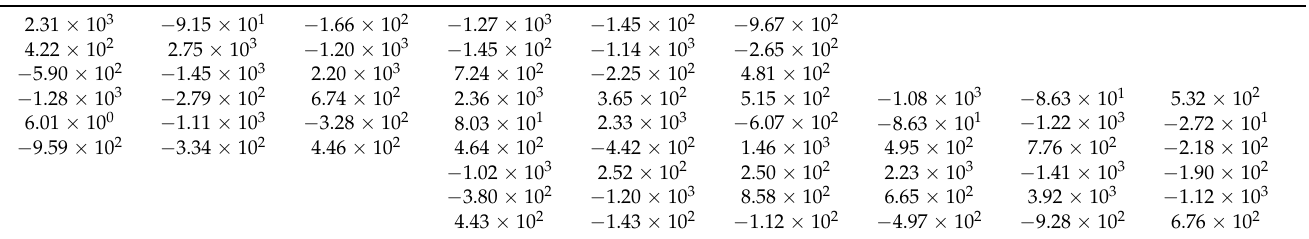
Table 3. Tangent stiffness matrix of the partial non-linear model in the final deformed configuration obtained applying F 2 y = 50 ( µ N).